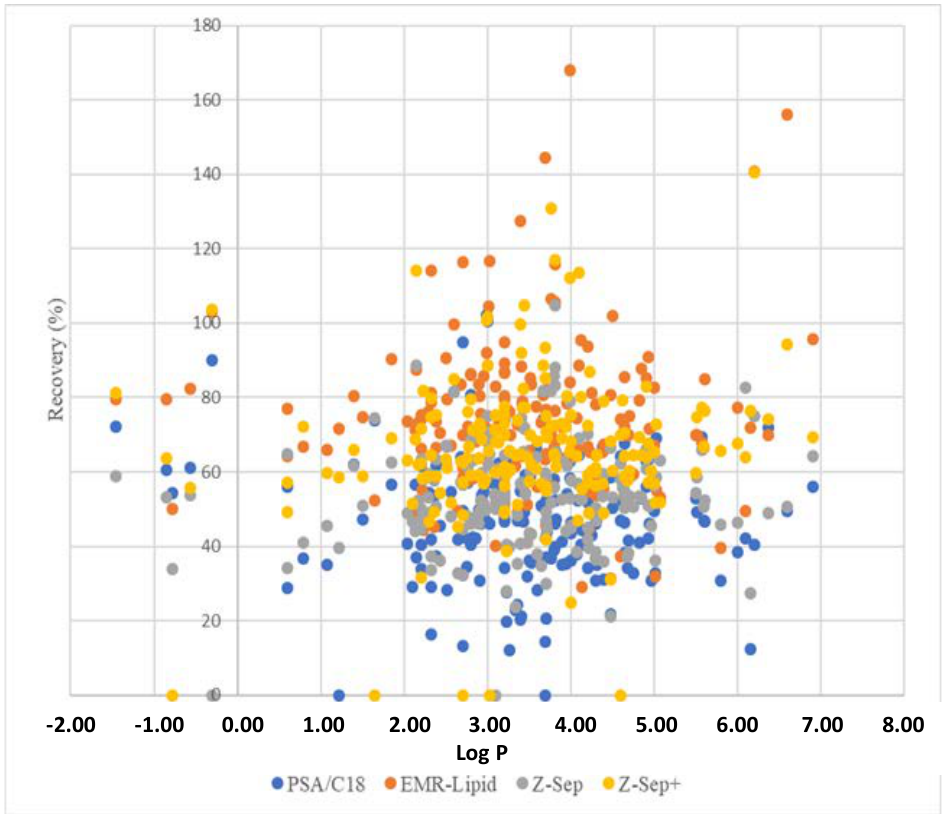
Figure 3. Relationship between Log P and pesticide recoveries from rapeseed samples using different purification adsorbents.